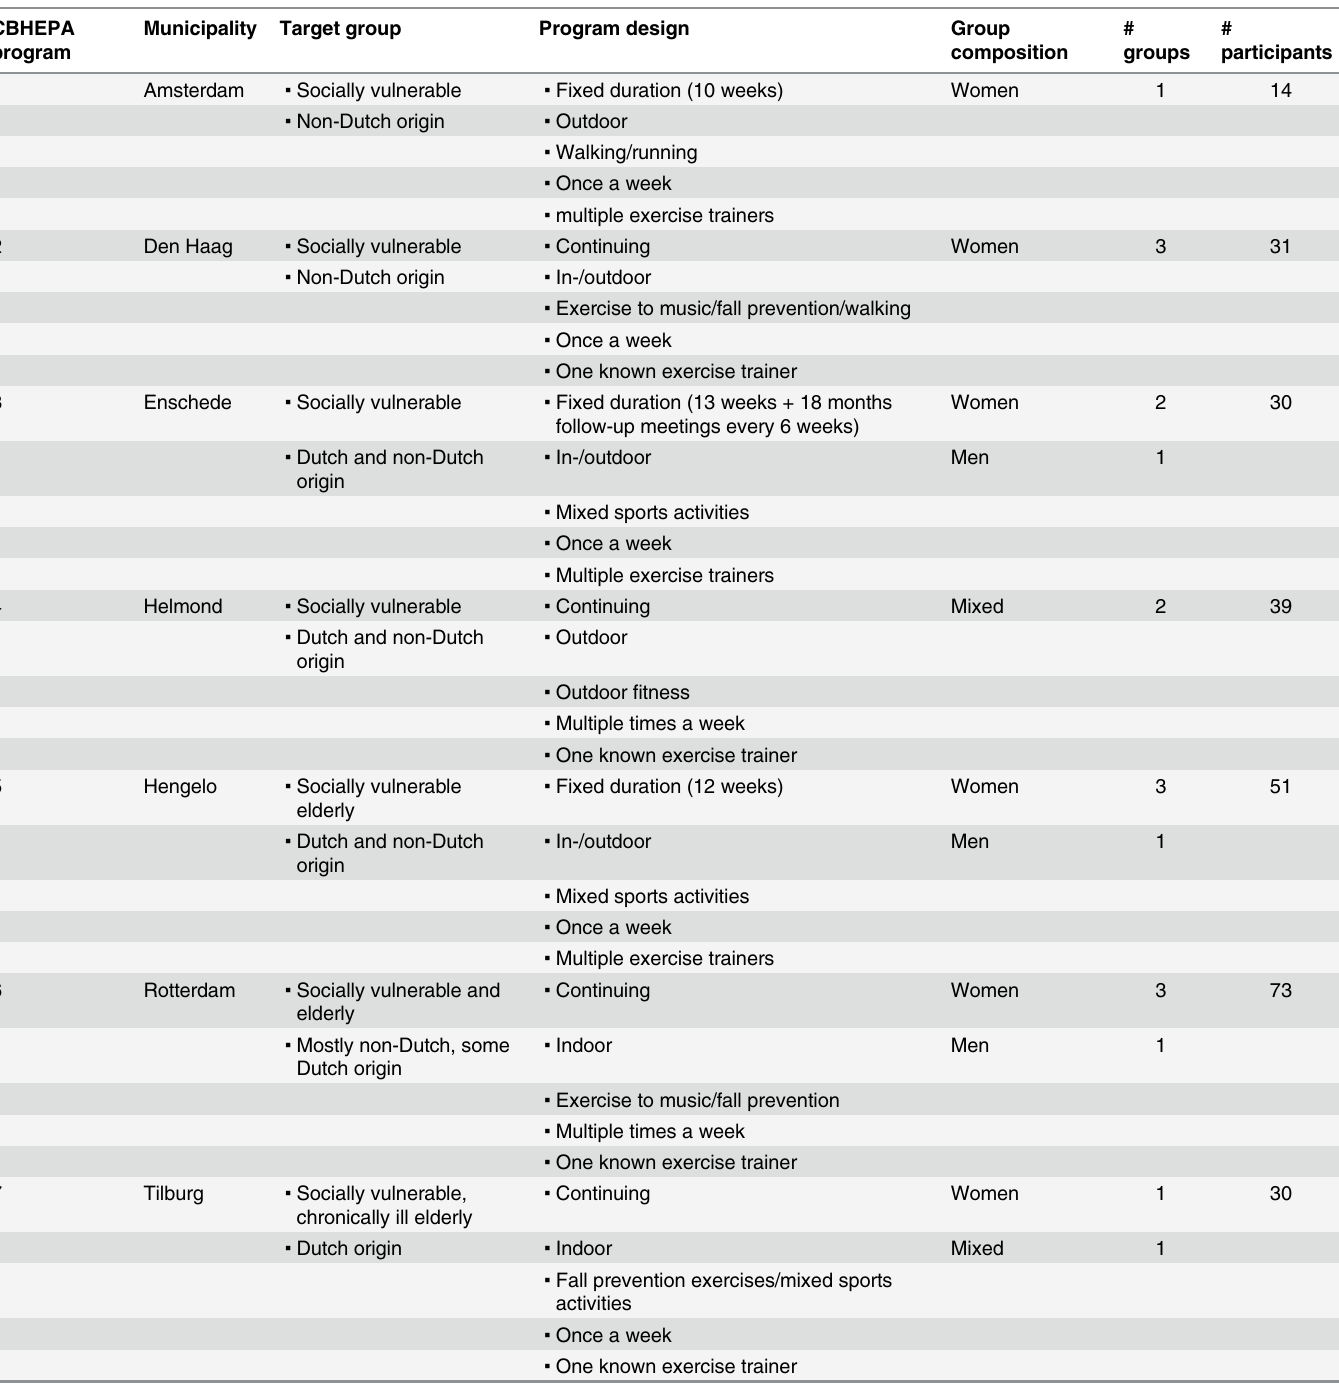
Table 1. Overview of CBHEPA programs